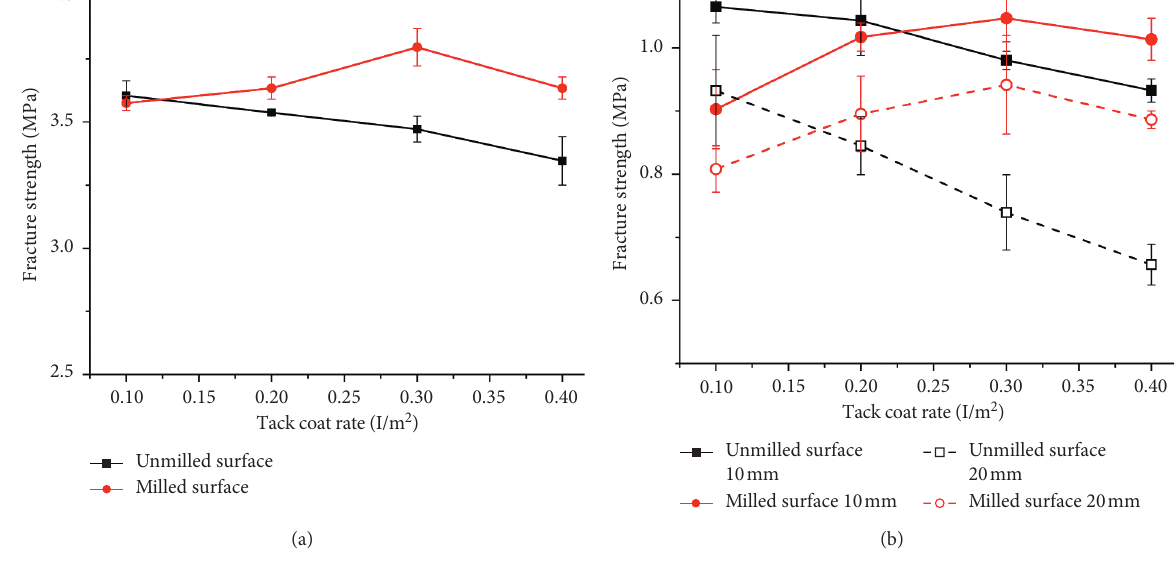
Figure 6: Fracture strength. (a) − 10 ° C and (b) 25 °